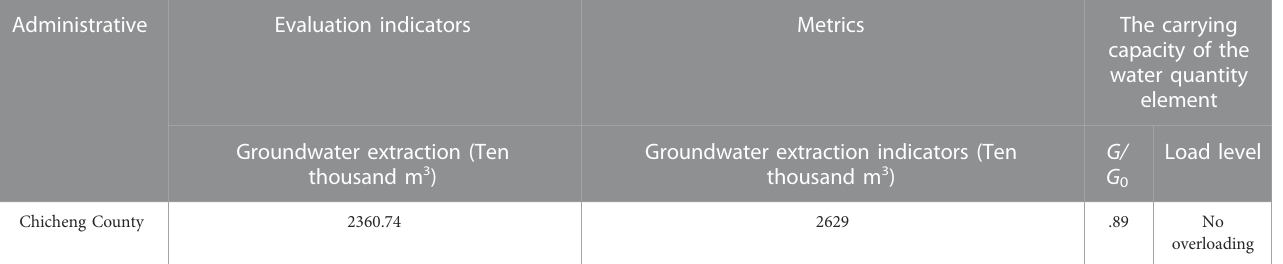
TABLE 4 Groundwater carrying status evaluation table for the current year (2018). Administrative